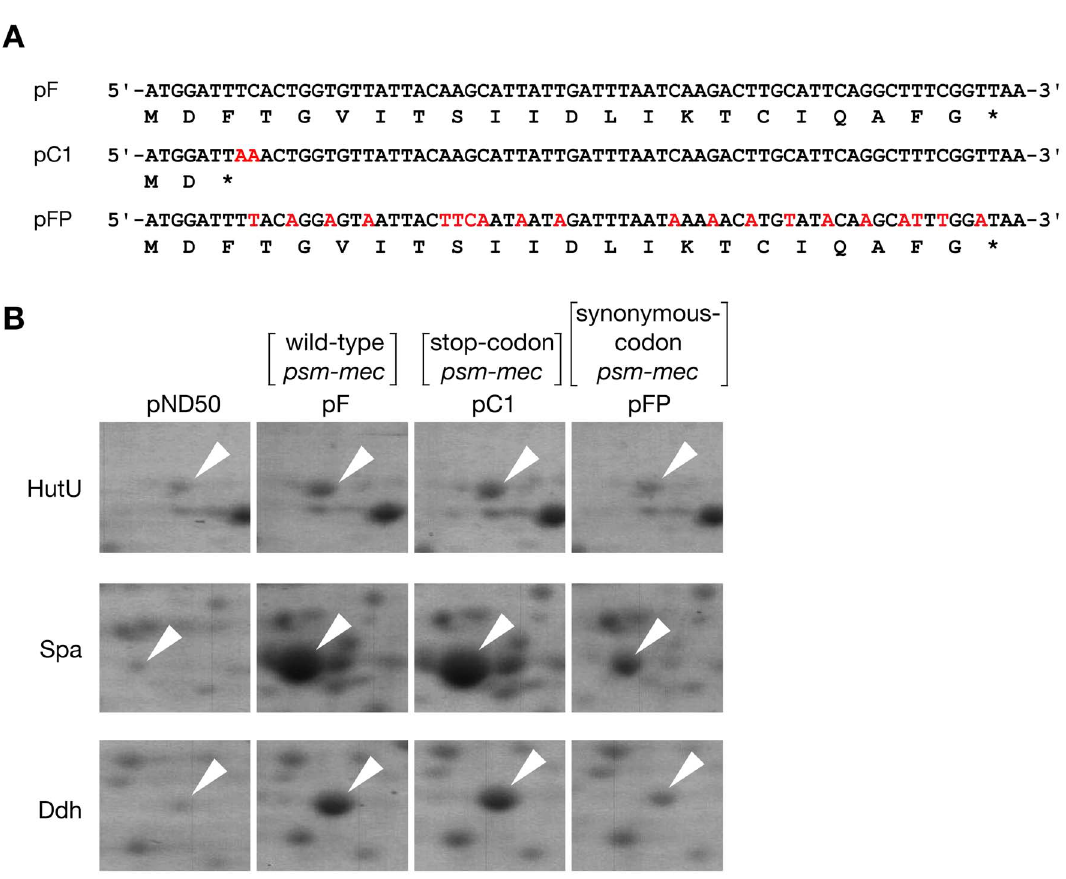
Figure 1. psm-mec RNA increased the amount of HutU, Spa, and Ddh in CA-MRSA FRP3757 (USA300). ( A ) The nucleotide sequence of the psm-mec ORF in pF, the stop-codon introduced sequence of psm-mec ORF in pC1, and the synonymous-codon substituted sequence of psm-mec ORF in pFP are shown. The substituted nucleotides are colored in red. The amino acid sequence of PSM-mec protein is shown below the respective nucleotide sequence. ( B ) Cell extract of FRP3757 strain that was transformed with empty vector (pND50), psm-mec (pF), mutated psm-mec harboring a stop codon (pC1), or mutated psm-mec harboring synonymous codon substitutions (pFP) was analyzed by two-dimensional electrophoresis. Proteins were stained with Coomassie Brilliant Blue. The protein spot was excised and identified by matrix-assisted laser desorption ionization time- of-flight mass spectrometry ( Table S1 ).